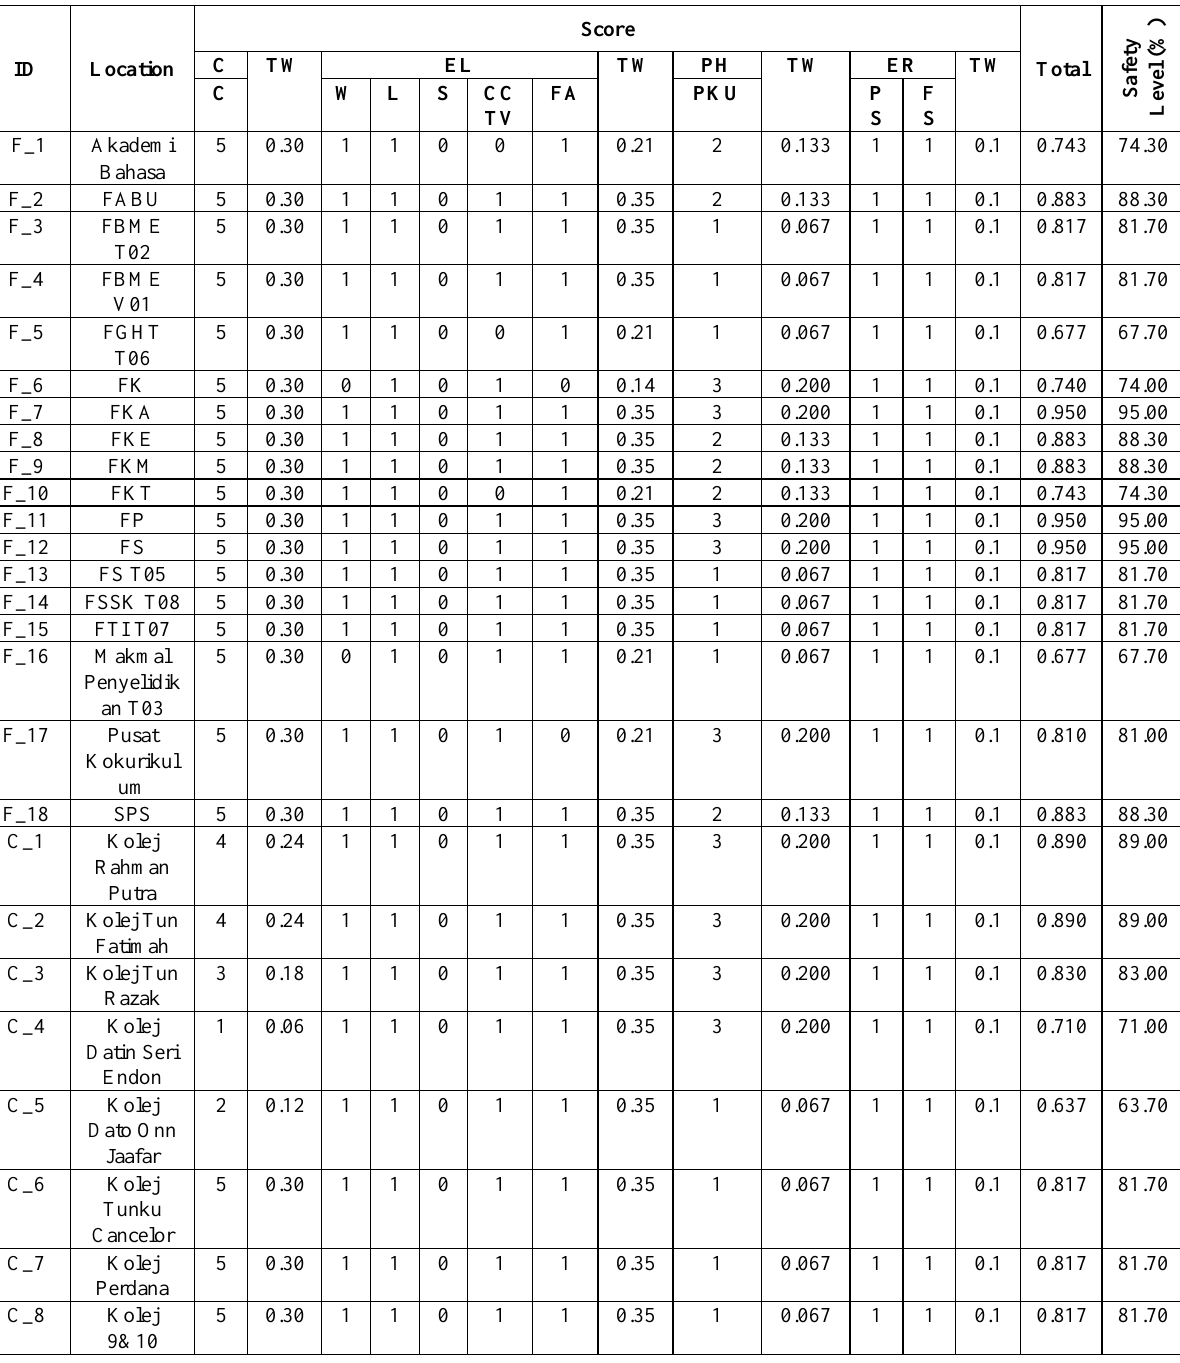
Figure 6. Result of Analysis for Emergency Response